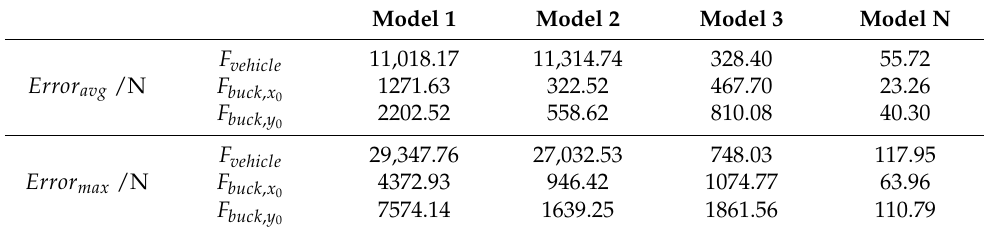
Figure 15. Comparison and error of bucket force in the x direction for each model. ( a ) Comparisons in the x direction between calculated bucket force and added force; ( b ) Absolute errors of calculated bucket force in the x direction. Table 1. Absolute error comparison for each